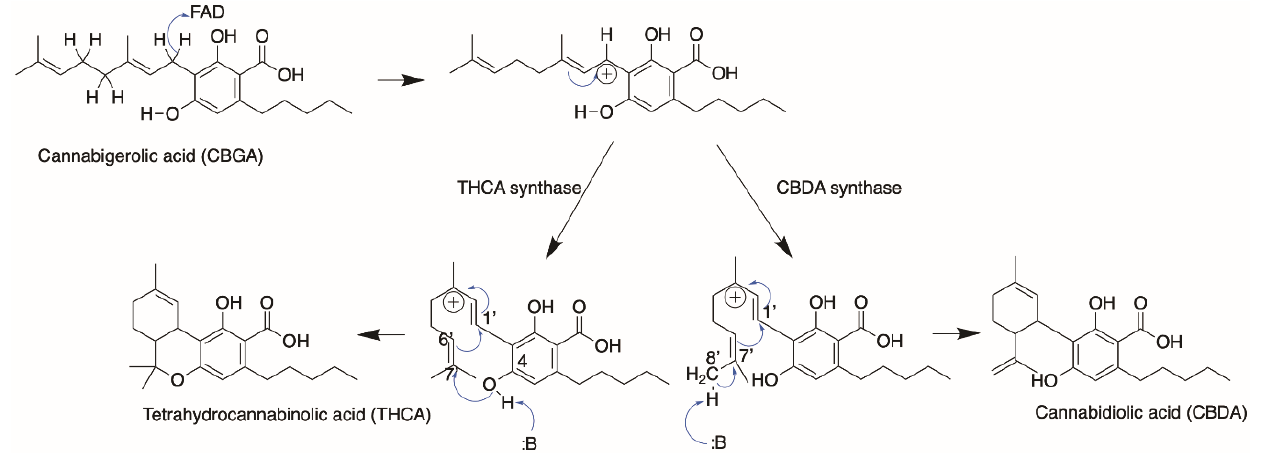
Figure 11. Postulated reaction mechanism between THCA and CBDA synthase forming THCA and CBDA products.